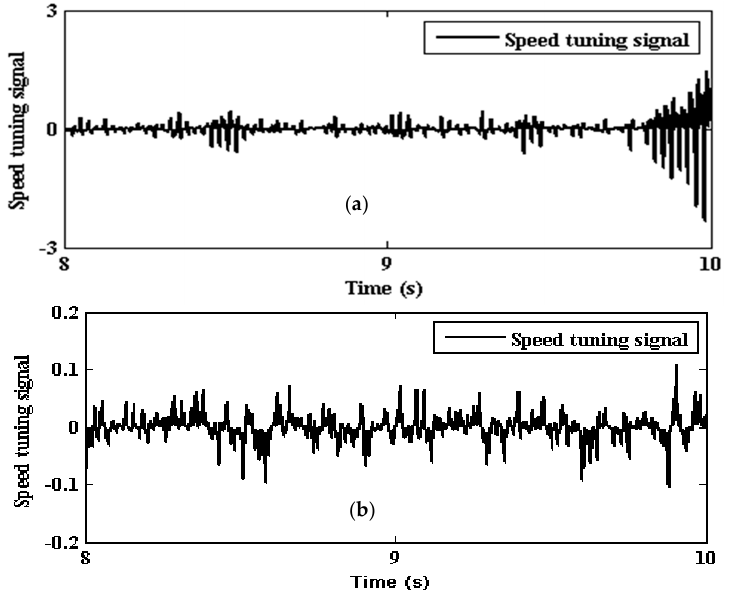
Figure 20. Speed tuning signal for 50% incorrect setting of stator resistance (R s ) and rotor time constant (T r ) for ( a ) SMLO 1, and ( b ) SMLO 2.